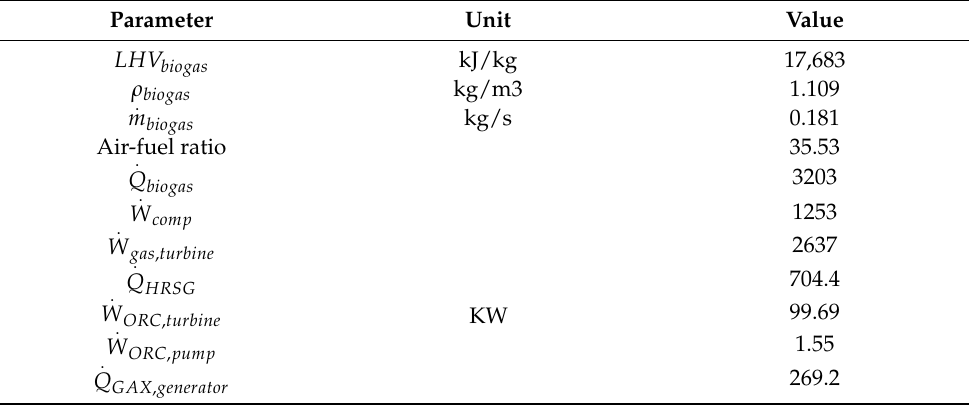
Table 5. Simulation results of the multigeneration